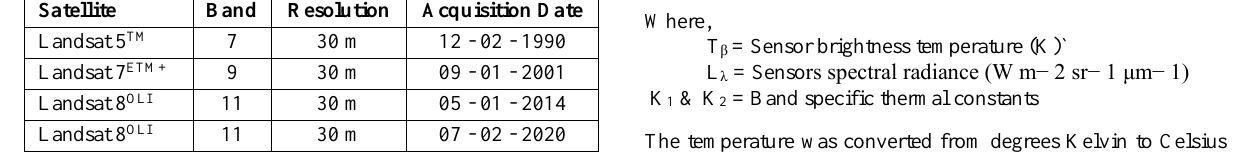
Table 1: Landsat data used in the study GEE cloud computing infrastructure facilitates advanced processing and analysis of images (Ermida et al., 2020). The L_1T Landsat imageries are calibrated to correct radiometric and geometric distortion. Prior to image analysis an atmospheric correction is performed. The acquired raw bands were converted to top of atmosphere (TOA) reflectance and radiance from digital numbers (DN) (Cetin et al., 2008). The multispectral bands were used to obtain land cover classes and Normalized Difference Vegetation Index (NDVI). While the TIR bands were used to retrieve LST. The methodology is summarized in (Figure 2).